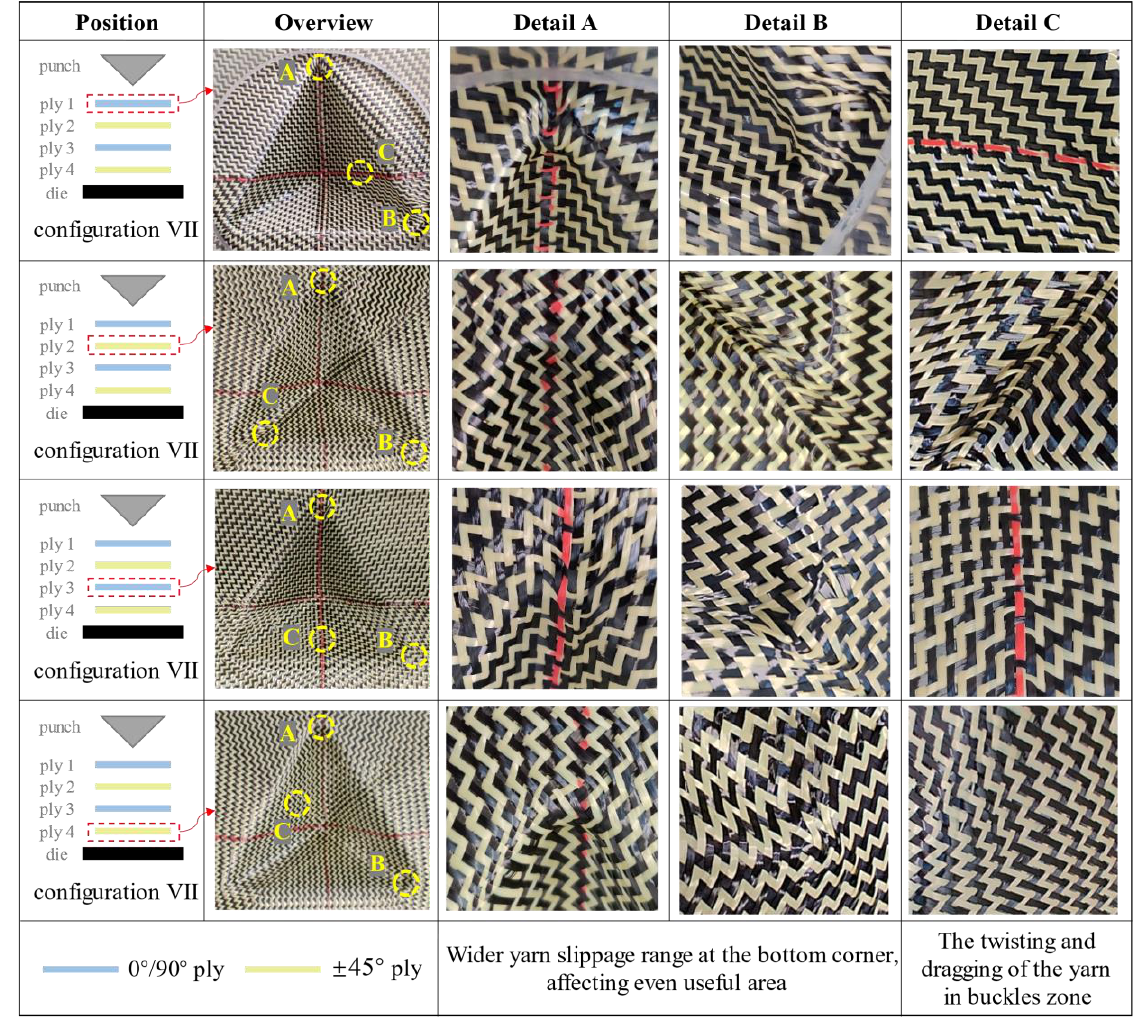
Figure 20. The deformation of each ply in configuration VII. Differences in relative deformation patterns between plies lead to a wider range of yarn slippage at the bottom corner, and yarn pull-out was observed in the buckles zone.